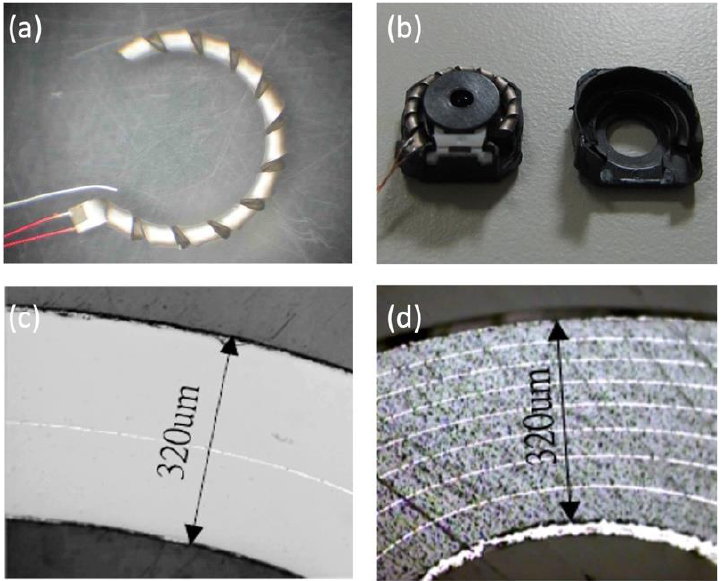
Figure 1. ( a ) Helimorph actuator and ( b ) camera module manufactured by the former Sunnytec Electronics licensed by the former One Limited. ( c ) Cross-section of a 2-layer Helimorph. ( d ) Cross section of an 8-layer Helimorph.